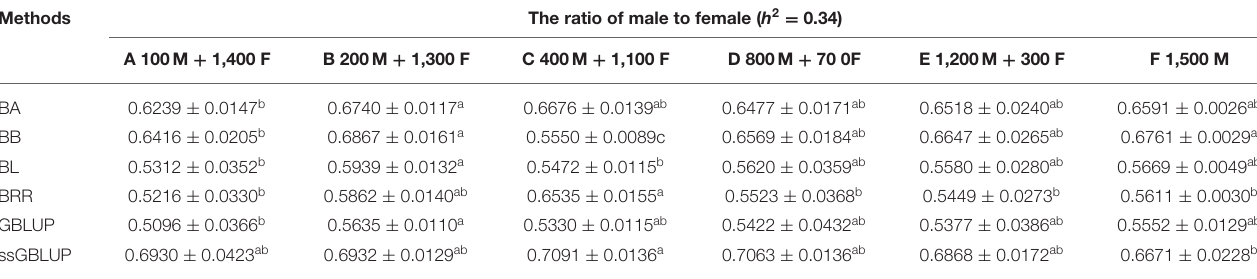
TABLE 9 | Accuracy of GEBV in six levels ratio of male to female with heritability of fiber diameter under different models. Methods The ratio of male to female ( h 2 = 0.34)